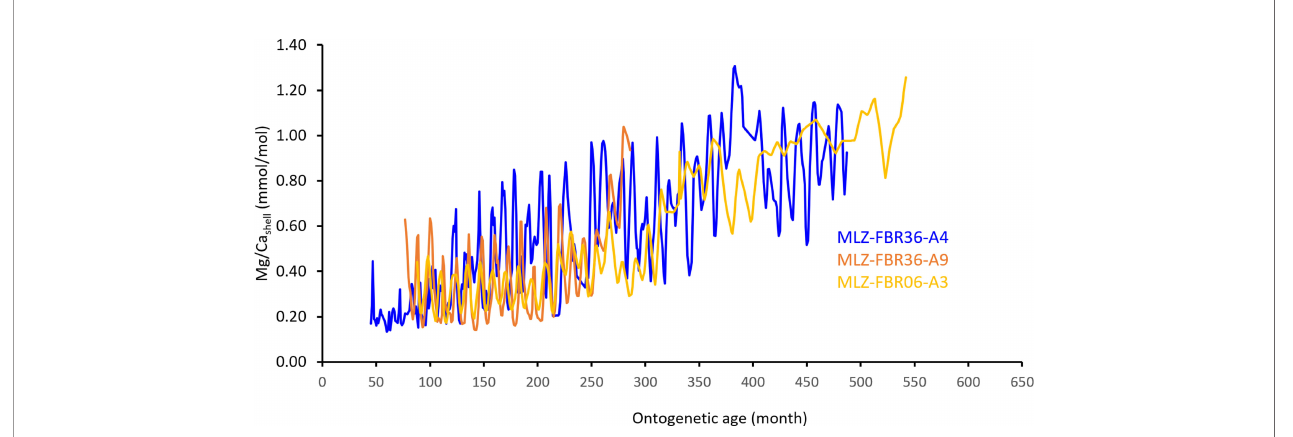
FIGURE 6 | Mg/Ca shell chronologies (monthly resolution) of long-lived specimens of A. islandica (MLZ-FBR36-A4), A. elliptica (MLZ-FBR36-A9) and A. borealis (MLZ- FBR06-A3) reveal distinct seasonal oscillations and a gradual increase